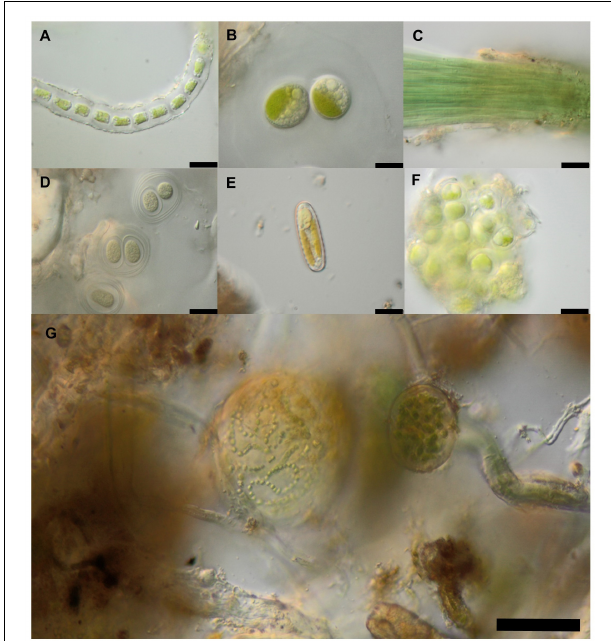
FIGURE 5 | Microphotographs of direct microscopy observations of biocrust material. (A) filament of Ulothrix- like algae; (B) Mesotaenium cf. chlamydospora ; (C) Microcoleus vaginatus ; (D) Gloeocapsa sp.; (E) Surirella sp.; (F) Apatococcus lobatus ; (G) Nostoc sp. colonies and Micocoleus vaginatus filaments between soil particles (brownish). Scale bars indicates 10 µ m (A–F) and 50 µ m (G) .